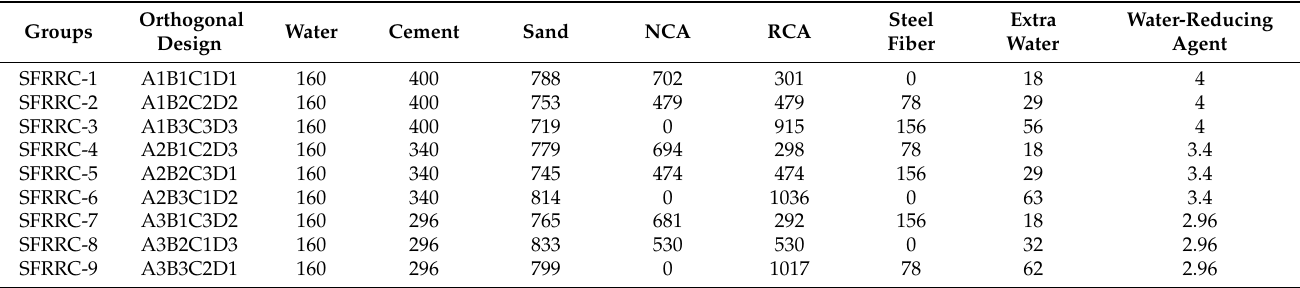
Table 5. Mixture proportions of specimens (kg/m 3 ).